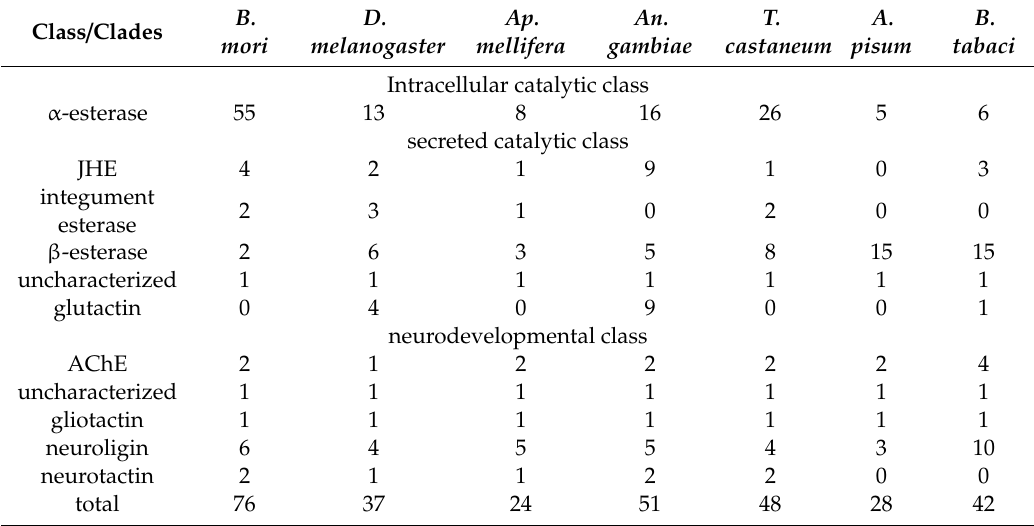
Table 1. The distribution of carboxylesterase (COE) genes in B. tabaci MED and other insects Class /